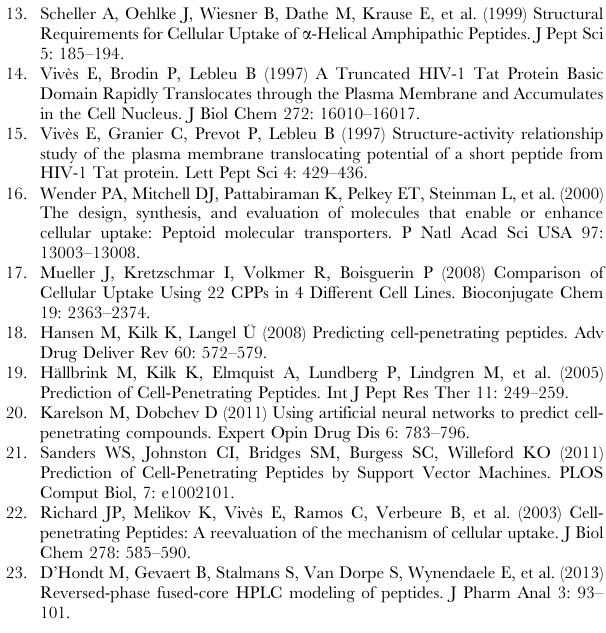
Figure 4. Schematic representation of the main CPP chemical classes from our dataset. Figure S1 Score plot of the first versus the second principal component of the PCA-analysis of 186 peptides after dividing their descriptors by the molecular weight. The colors of the clusters correspond with the clusters found in the score plot of the PCA-analysis using the original descriptors (Figure 2). For each cluster, some examples of peptides are indicated. Table S1 Overview of the 186 (non-) CPPs, including their CP-response. Table S2 List of cell-penetrating peptides whose CP- response is an outlier.